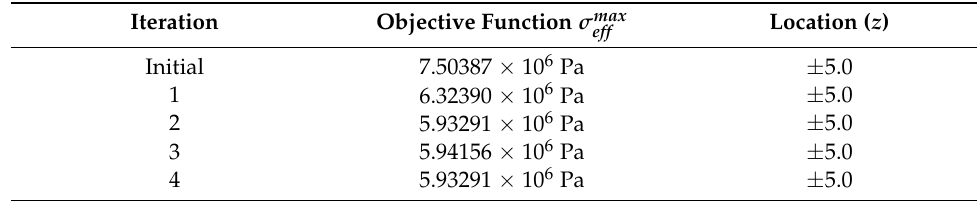
Table 3. The iteration history of objective function.